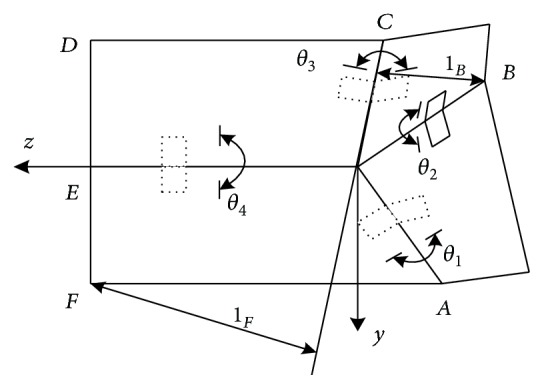
State of wings at θ3 = 135°.